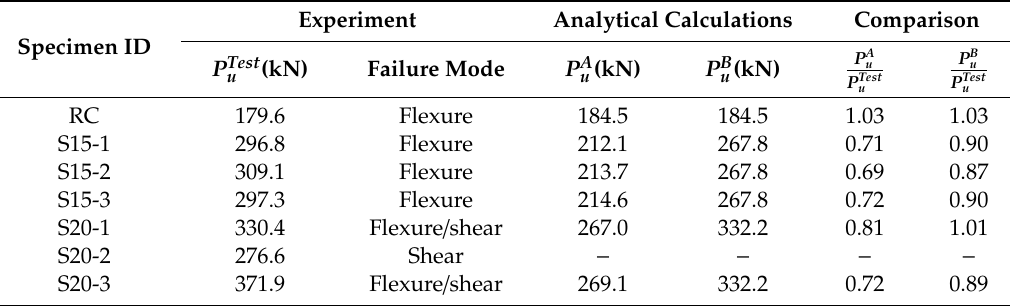
Table 6. Summary of the test and analysis results for the slab specimens.